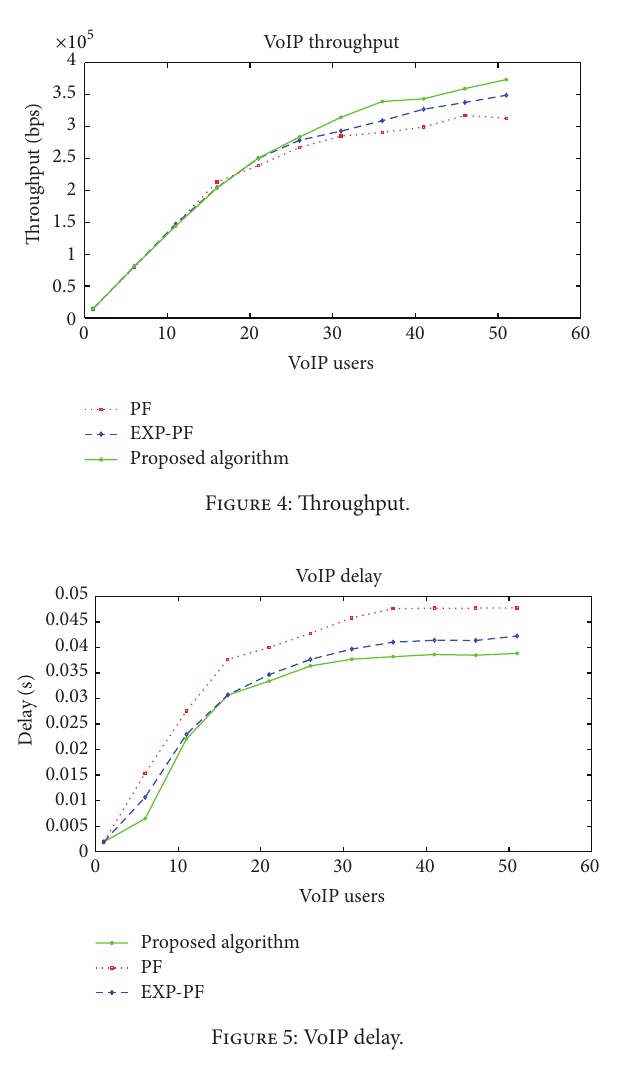
Figure 5: VoIP delay.